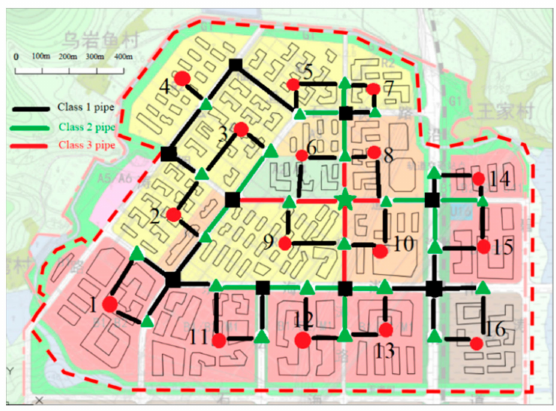
Figure 12. The result of the Pipe Diameter Grading in the study